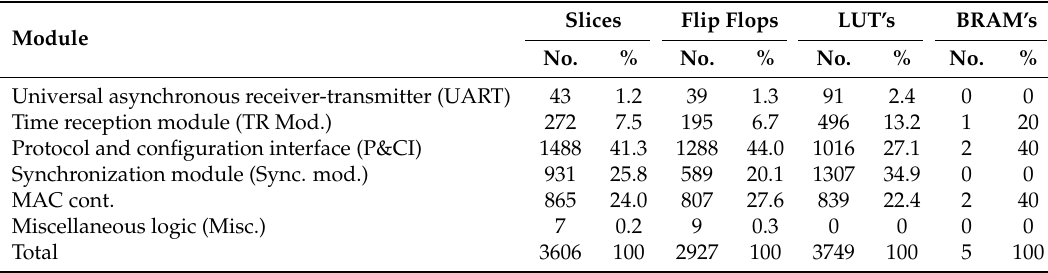
Table 6. Number of internal resources per